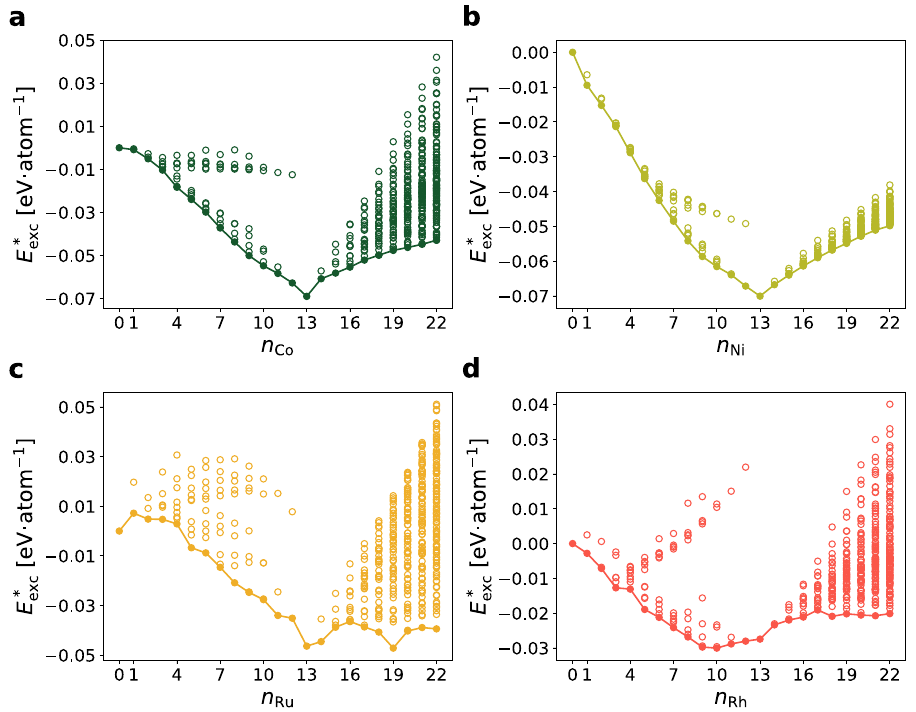
Fig. 4 Energetic stability for core – shell clusters. The excess energies ( E (cid:3) ) for core – shell structures of ( a ) Cu 55- n Co n , ( b ) Cu 55- n Ni n , ( c ) Cu 55- exc n Ru n , and ( d ) Cu 55- n Rh n alloy clusters as a function of dopant concentratio n , where n M is the number of dopant metal atoms in the 55-atom cluster. The lowest excess energies for each dopant concentration are connected by a solid